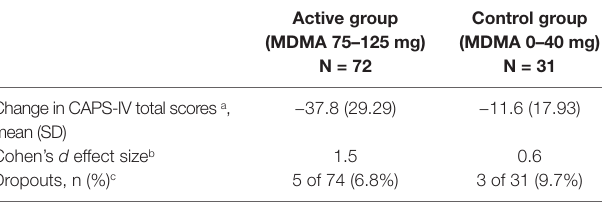
TABLE 1 | Pooled CAPS-IV data from six phase 2 MAPS-sponsored studies of MDMA-assisted psychotherapy. Active group (MDMA 75–125